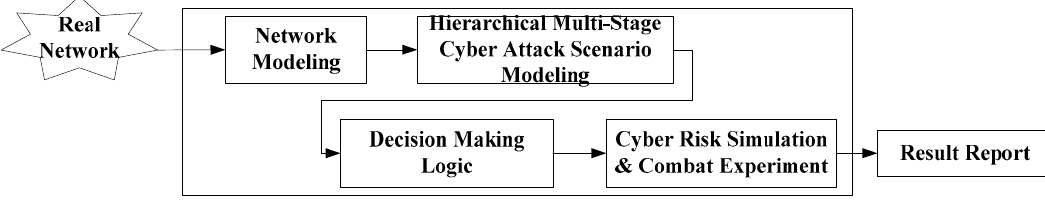
Figure 3. Conceptual diagram of the analysis system.